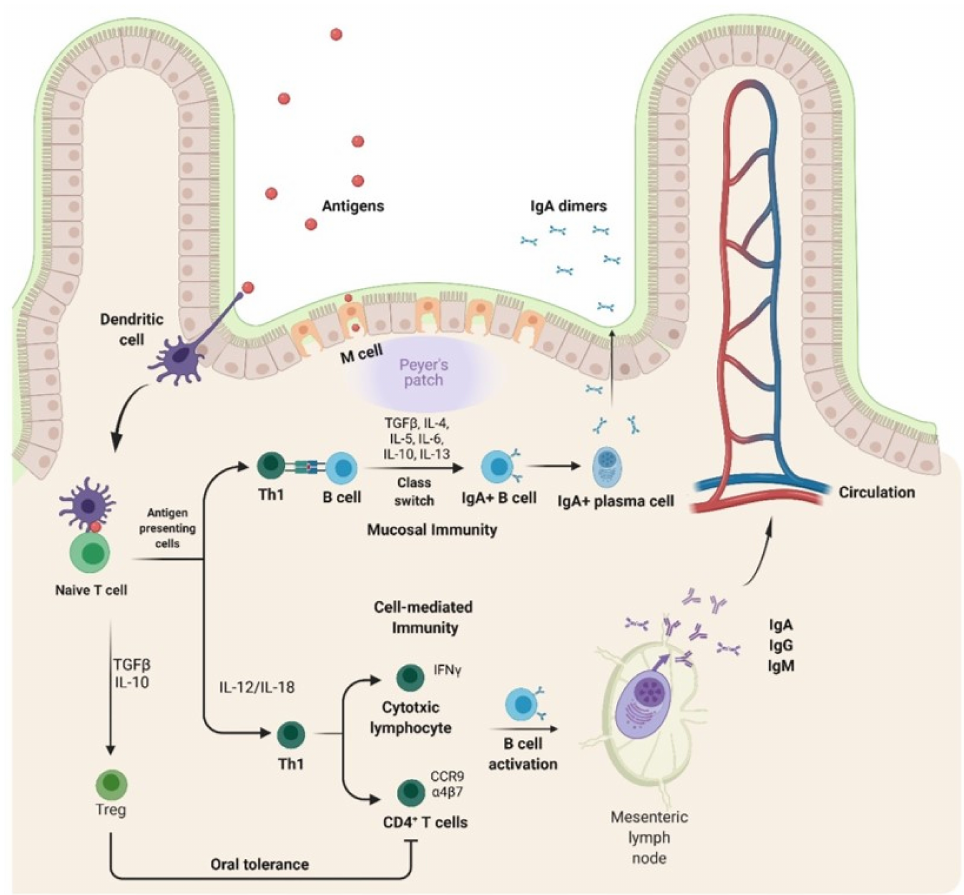
Figure 1. Mechanism of mucosal